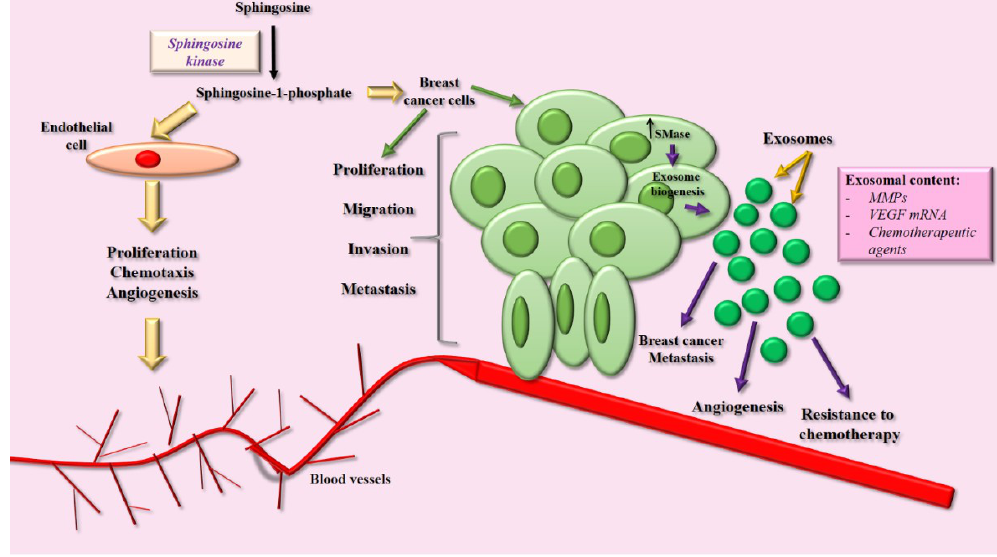
Figure 4. Ceramides and sphingolipids in breast cancer progression. S1P is a critical molecule involved in the modulation of angiogenesis. In endothelial cells, it has been demonstrated that S1P promotes proliferation, migration, and chemotaxis, resulting in the generation of intra-tumoral blood vessels that facilitate the process of metastasis. Moreover, S1P induces migration and invasion of breast cancer cells, promoting the process of tumor intravasation. Finally, in tumor cells, the SMase enzyme shows high activity, promoting the biogenesis and secretion of exosomes, extracellular vesicles that modulate angiogenesis, metastasis, and resistance to chemotherapy. Image adapted from references: